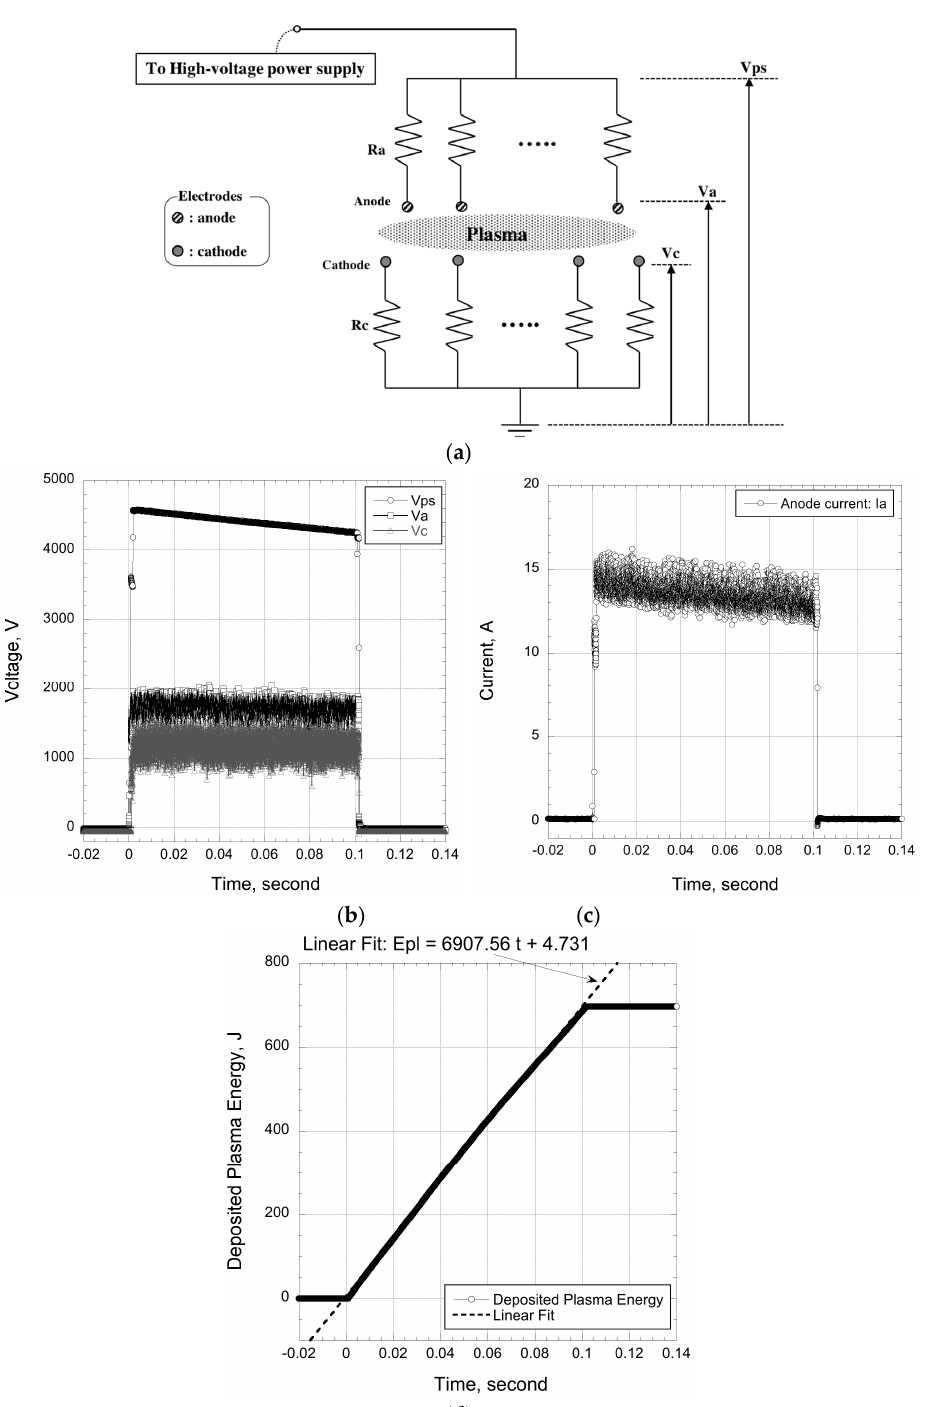
Figure 4. Electrical circuit and typical plots of electric parameters: ( a ) Schematics of electrical circuit and measured voltages; ( b ) voltage traces; ( c ) anode current; ( d ) plot of deposited plasma energy and linear fit